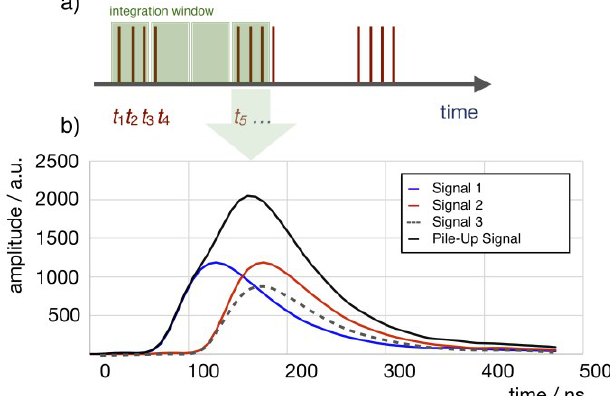
Figure 3.The residual signal of multiple events (Pile-Up Signal), which are detected in the same integration window (event 1: signal 1, event 2: signal 2), is proportional to the deposited energy in the detector (tissue equivalent) and therefore to the ambient and directional dose. This also applied to for different energy depositions (signal 3) due to the equal weighting